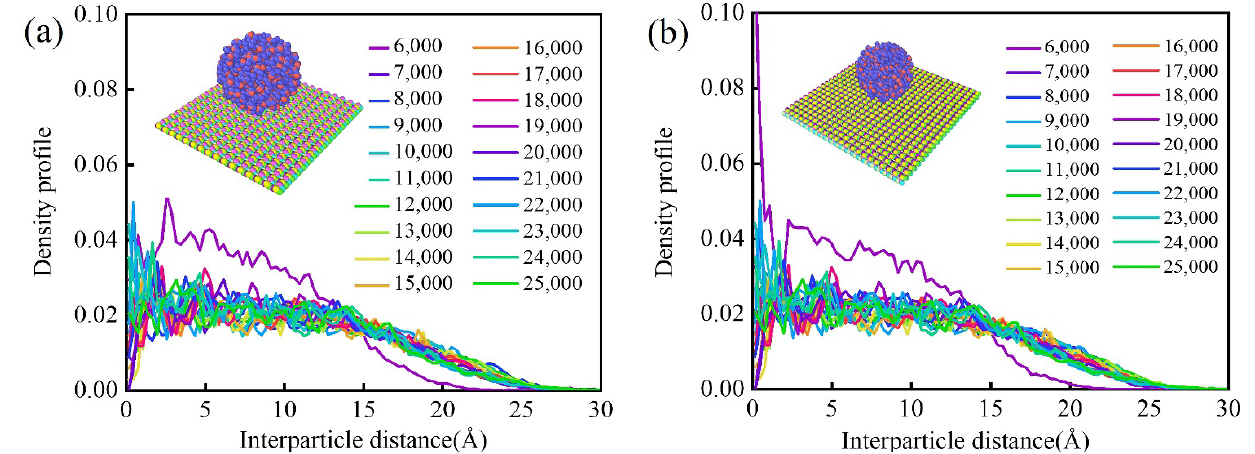
Figure 7. Wettability of water molecules on coatings. Density profiles of ( a ) graphene and ( b ) bi- phenylene.